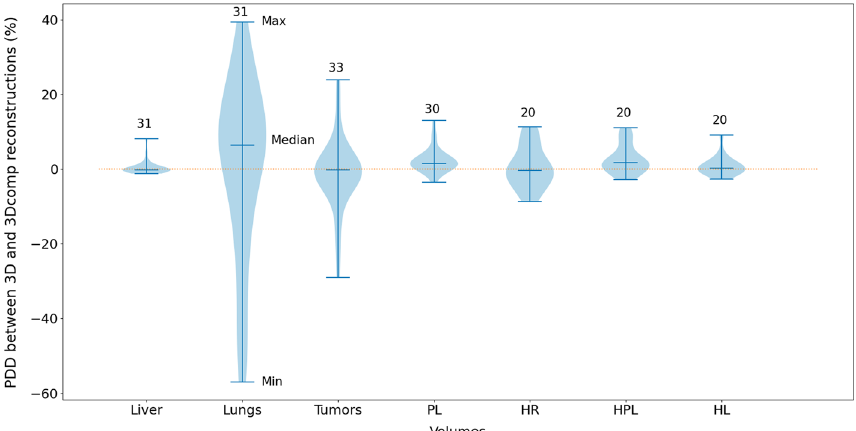
Fig. 2 Boxplots of percentages of dose difference (PDD) between 3D and 3Dcomp reconstructions for each VOI (liver, lungs, tumors, PL, HR, HL, HPL). The number of contours used is written above each